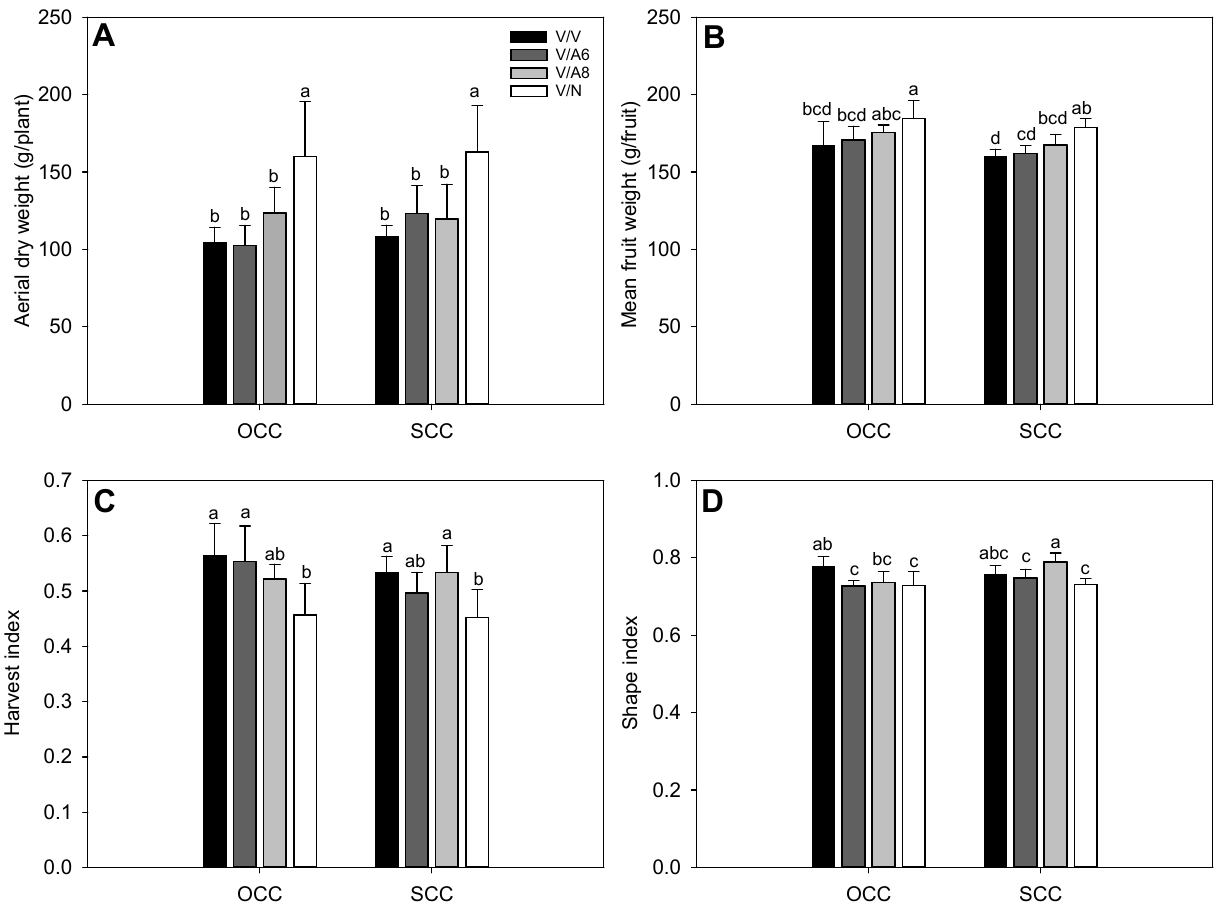
Figure 2. Aerial dry weight (ADW, g; ( A )), mean marketable fruit weight (g; ( B )), harvest index (HI; ( C )) and shape index (SI; ( D )) under optimal (OCC) and suboptimal (SCC) calcium conditions. The selected variety (V) was grafted onto the rootstocks A6 (V/A6), A8 (V/A8) and NIBER ® (V/N), as well as self-grafted (V/V). data are the mean values of n = 4 and bars correspond to the standard deviation. Different letters indicate significant differences at P < 0.05 (LSD